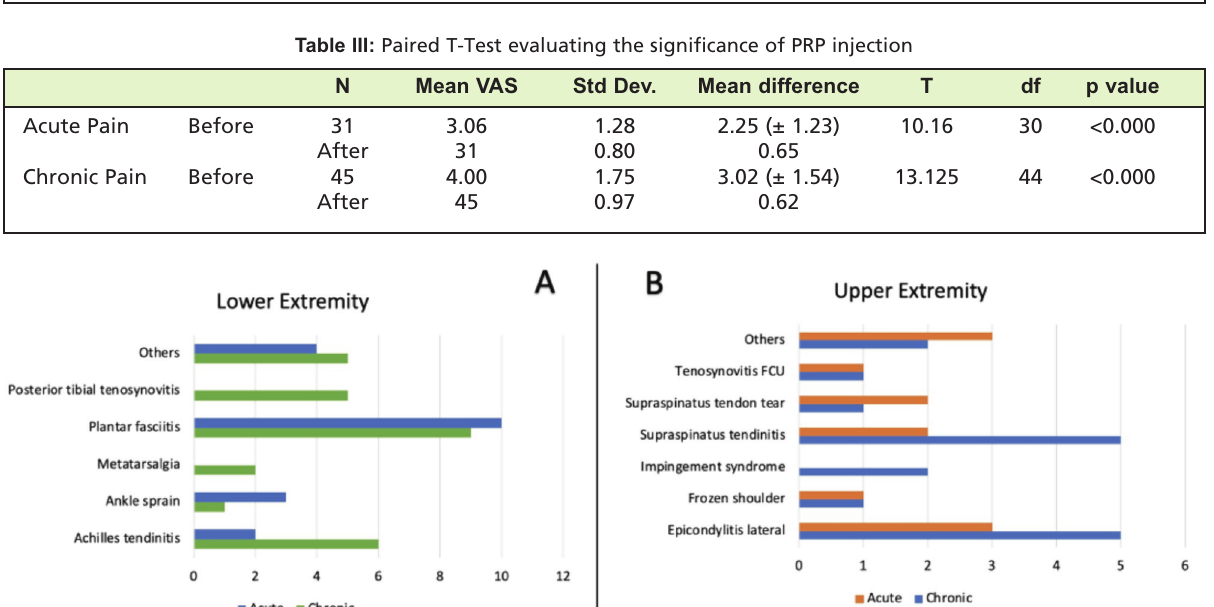
Distribution of soft tissue inflammation (upper extremity and lower extremity). (a) Chronic pain. (b) Acute Fig. 1: